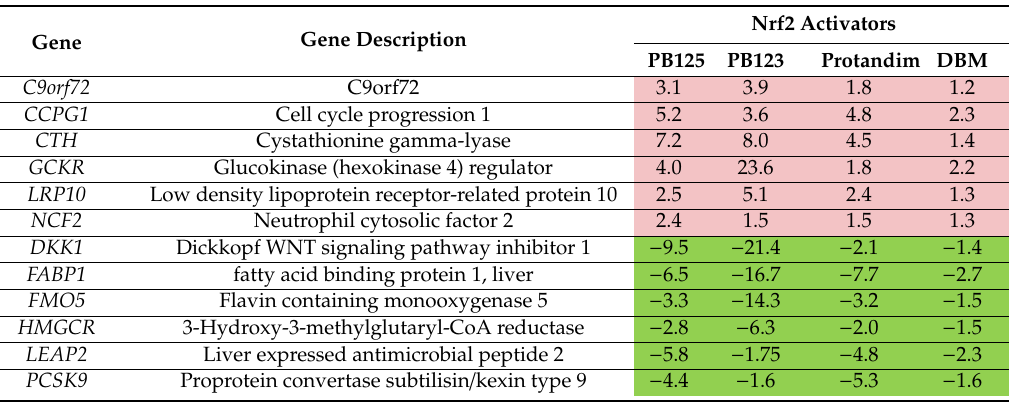
Table 3. Non-canonical Nrf2 genes that are consistently modulated in HepG2 cells by four di ff erent Nrf2 activators. The numbers reflect fold-induction of the respective mRNA levels based on averages of 3 independent microarray or RNA-seq experiments for PB125 treatment (16 µ g / mL), and single microarray experiments for the comparison treatments (PB123, Protandim, and dibenzoylmethane (DBM)). In every case these twelve genes were regulated in the same direction by all four Nrf2 activators (upregulation shaded in red; downregulation shaded in green).